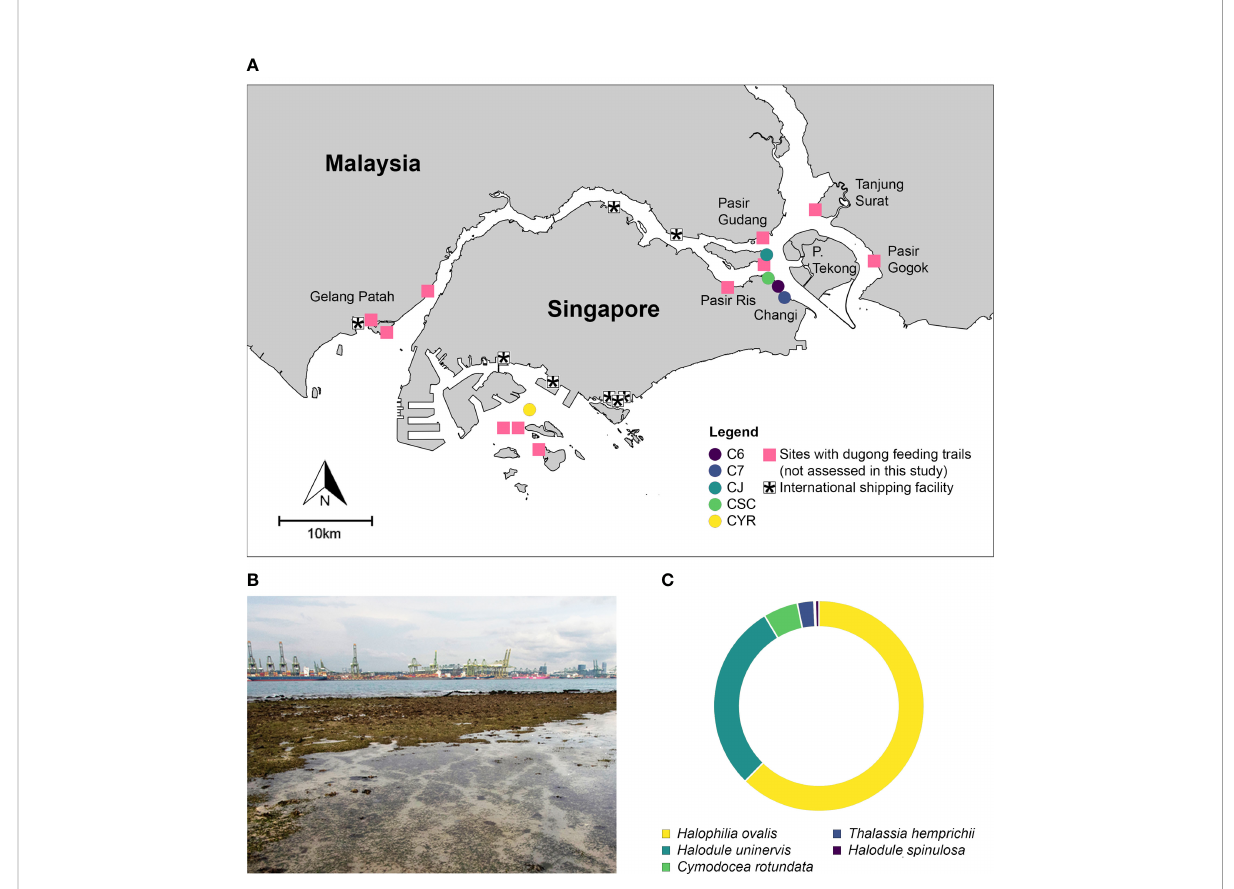
FIGURE 3 Dugong feeding trails along the coastlines of southern Johor and Singapore. (A) Location of sites where dugong feeding trails were reported and ascertained. (B) Dugong feeding trails along Terumbu Pandan, Cyrene Reefs, mere meters from international shipping lanes/facilities. (C) Proportion of seagrass species adjacent to an average dugong feeding trail within our fi eld survey